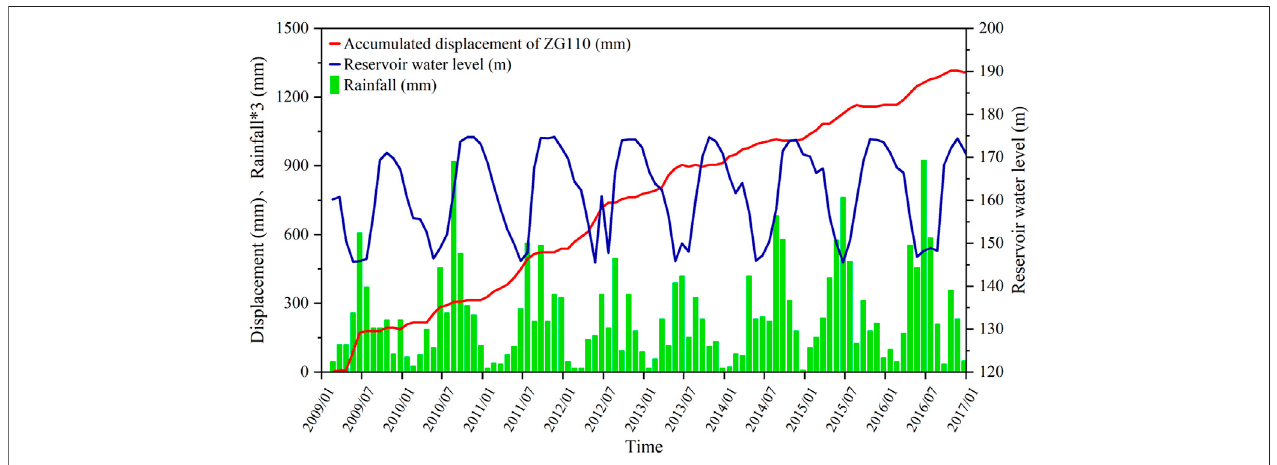
FIGURE3| Flowchartofthecomponents utilizedforlandslidedisplacementprediction. Decompositionofthecumulativedisplacementandthecontrollingfactors.